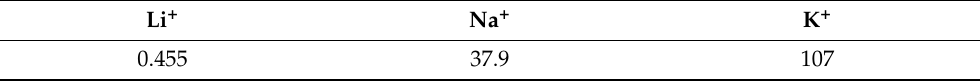
Table 2. Composition of the model solution (concentration ions Figure 7. Extraction isotherms. The organic phase consists of 0.05 M salicylate and 0.05 M TOPO in heptane at 25 °C. O/A = 1:1.